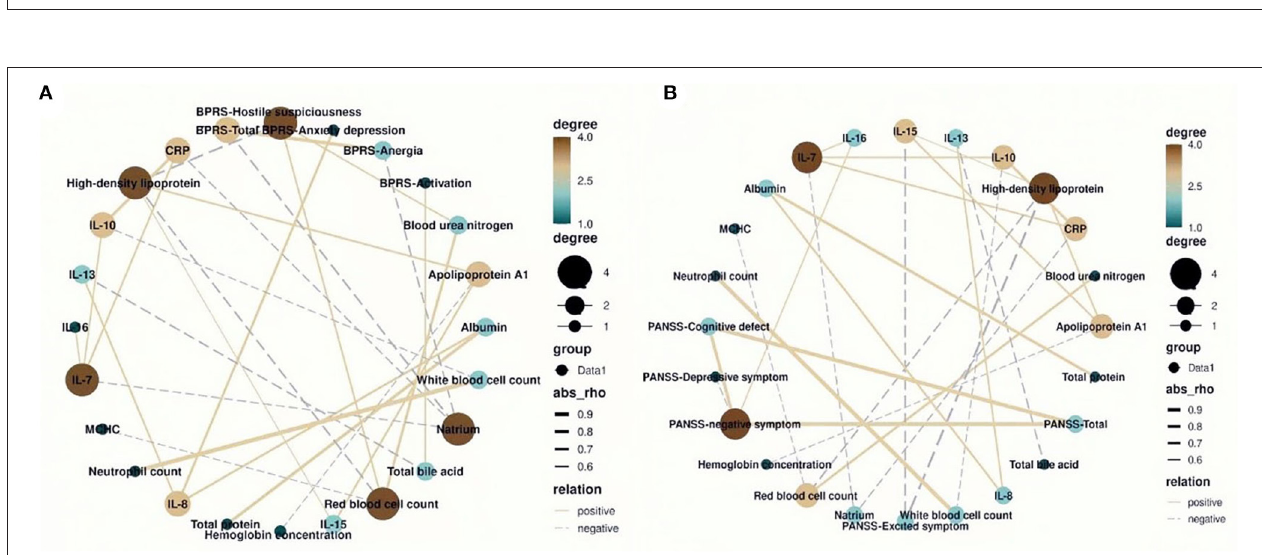
FIGURE 3 | The correlation network between blood routine, biochemical, and inflammatory factors and total and subscale scores of Brief Psychiatric Rating Scale (BPRS) and Positive and Negative Syndrome Scale (PANSS). (A) The natrium and red blood cell count had the highest degree of correlation with the BPRS (degree = 4). (B) The high-density lipoprotein had the highest degree of correlation with the PANSS (degree = 4).